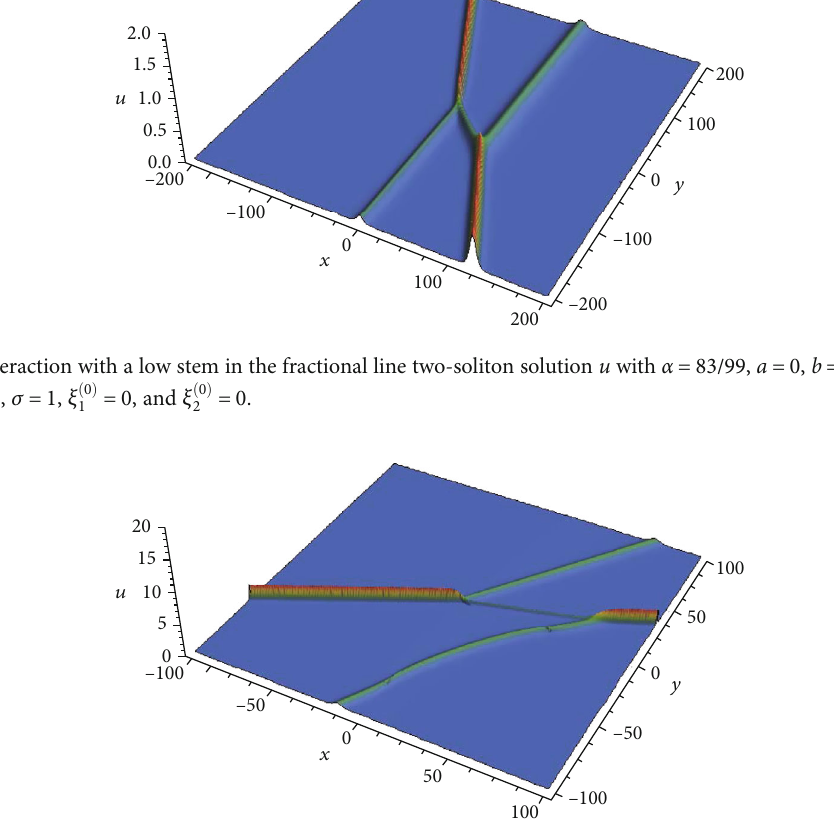
Figure 12: X-type interaction in the fractional line three-soliton solution u with α = 83/99 , a = 0 , b = 0 , c = 0 , k p 1 = − 1/4 , p 2 = − 3/4 , p 3 = − 7/4 , σ = 1 , ξ ð